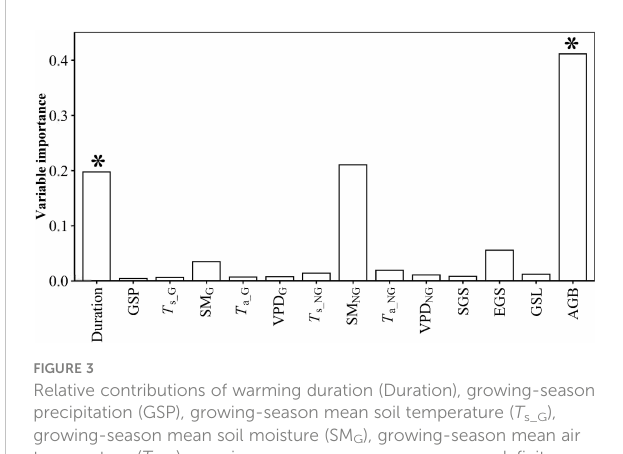
FIGURE 3 Relative contributions of warming duration (Duration), growing-season precipitation (GSP), growing-season mean soil temperature ( T s_G ), growing-season mean soil moisture (SM G ), growing-season mean air temperature ( T a_G ), growing-season mean vapor pressure de fi cit (VPD G ), non-growing-season mean soil temperature ( T s_NG ), non- growing-season mean soil moisture (SM NG ), non-growing-season mean air temperature ( T a_NG ), non-growing-season mean vapor pressure de fi cit (VPD NG ), start of growing-season (SGS), end of growing-season (EGS), growing-season length (GSL) and aboveground biomass (AGB) to precipitation use ef fi ciency (PUE). * indicates this variable had a signi fi cant in fl uence on PUE at p <0.05 level.